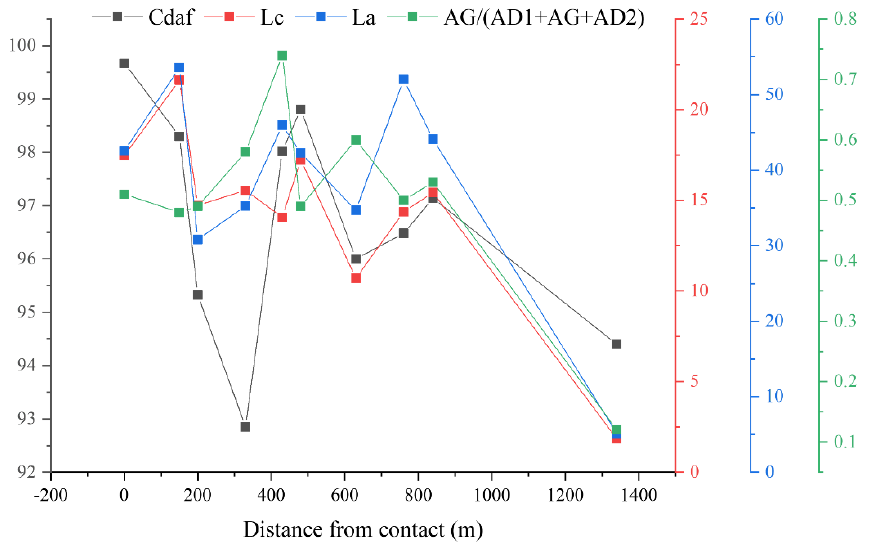
Figure 6. Relationships between Cdaf (%) content, the parameter ( L c , L a ) of grain size, Raman spectral parameter (AG/AD1 + AG + AD2), and distance from the contact horizon (m).